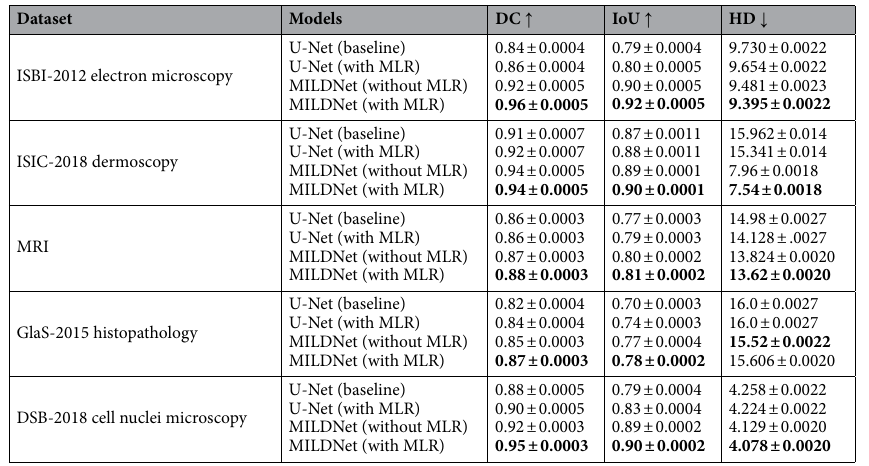
Table 4. The impact of the residual-of-residual skip connections (MLR blocks) on the segmentation accuracy using the validation sets. ↑ : The higher value is better; ↓ : The lower value is